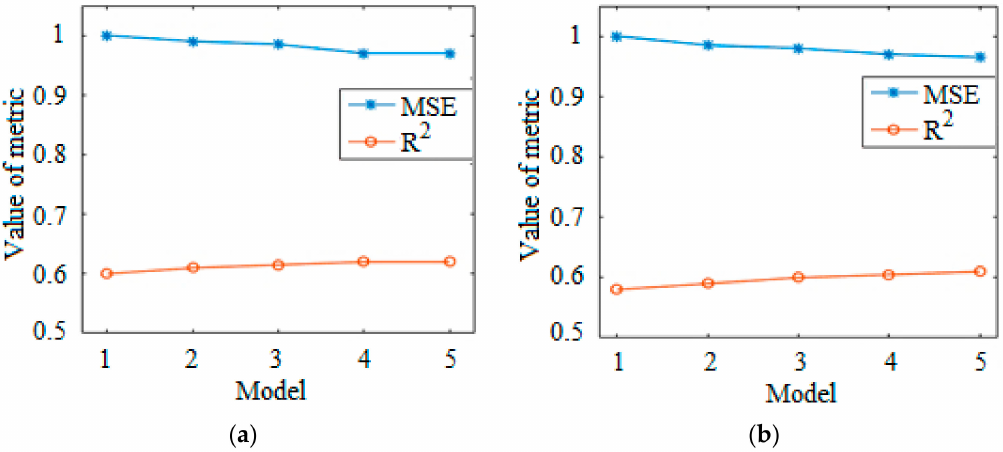
Figure 11. The predicted metric value versus ANN models, ( a ) 1–5, ( b ) 5–10 with variant neuron numbers.